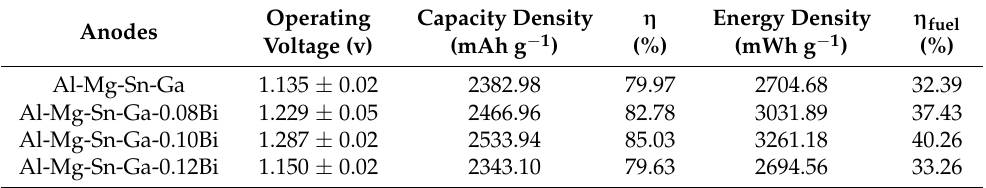
Figure 9. Discharge behavior of Al-air batteries at a current density of 100 mA cm − 2 . Table 5. Discharge performances of Al-air batteries with the Al-Mg-Sn-Ga-xBi alloys.